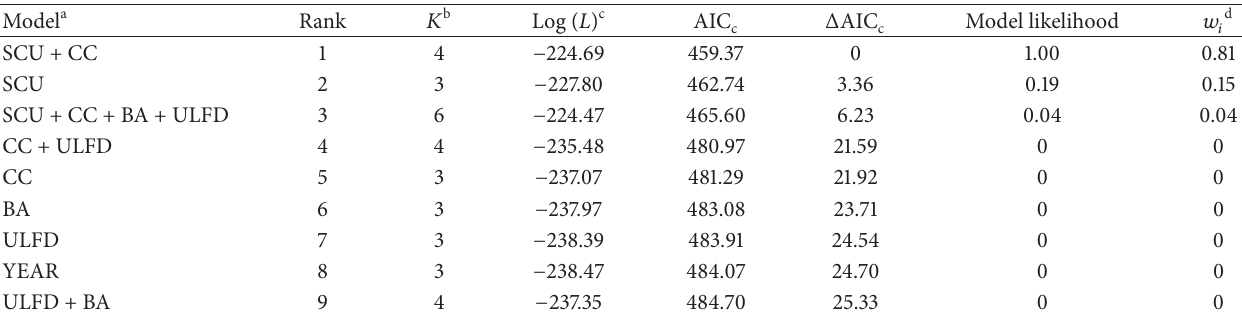
Table 2: Akaike’s Information Criterion adjusted for small sample size (AIC the influence of stem cover units (SCU = 3 × coniferous saplings + deciduous saplings/ha), percent overhead canopy closure (CC), basal area (m 2 /ha) of snags and deciduous and coniferous trees (BA), and percent understory lateral foliage density (ULFD) on snowshoe hare pellet density (pellets/ha/month) within 25 microsite plots during winters 1996 and 1998, north-central Maine. Model a Rank 𝐾 b Log ( L ) c SCU +